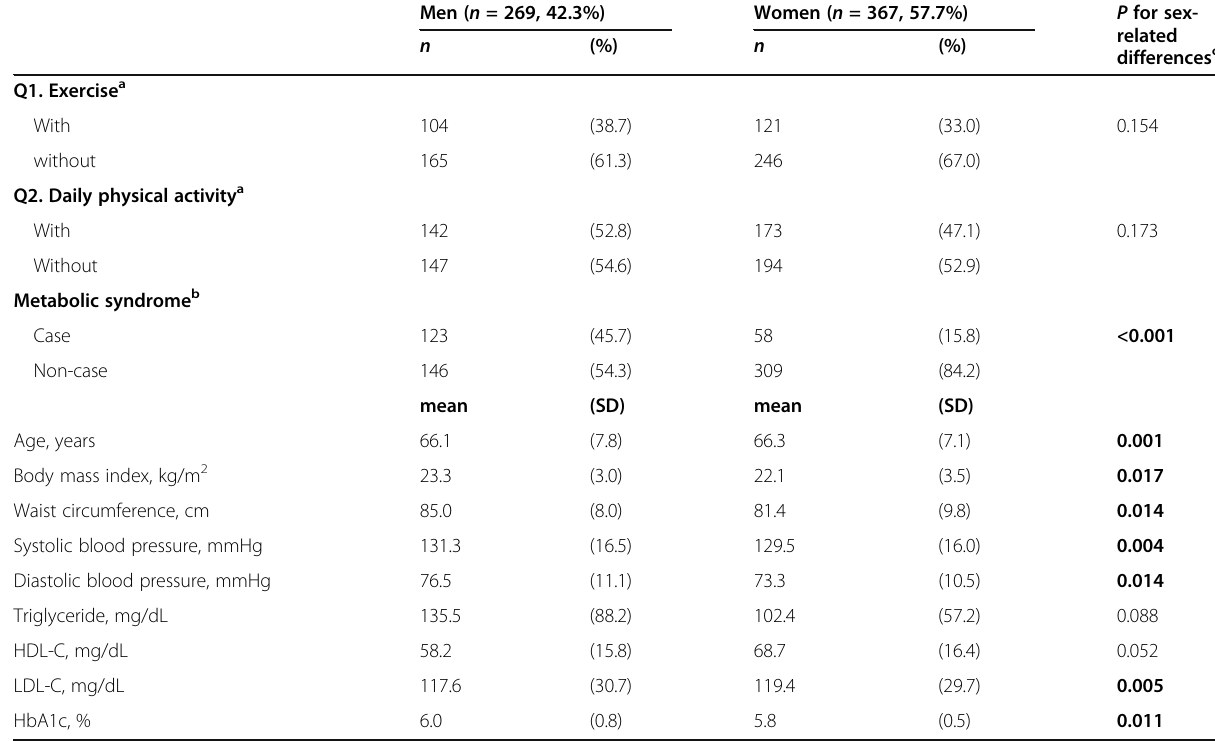
Table 2 Participant characteristics and physical activities ( n = 636)